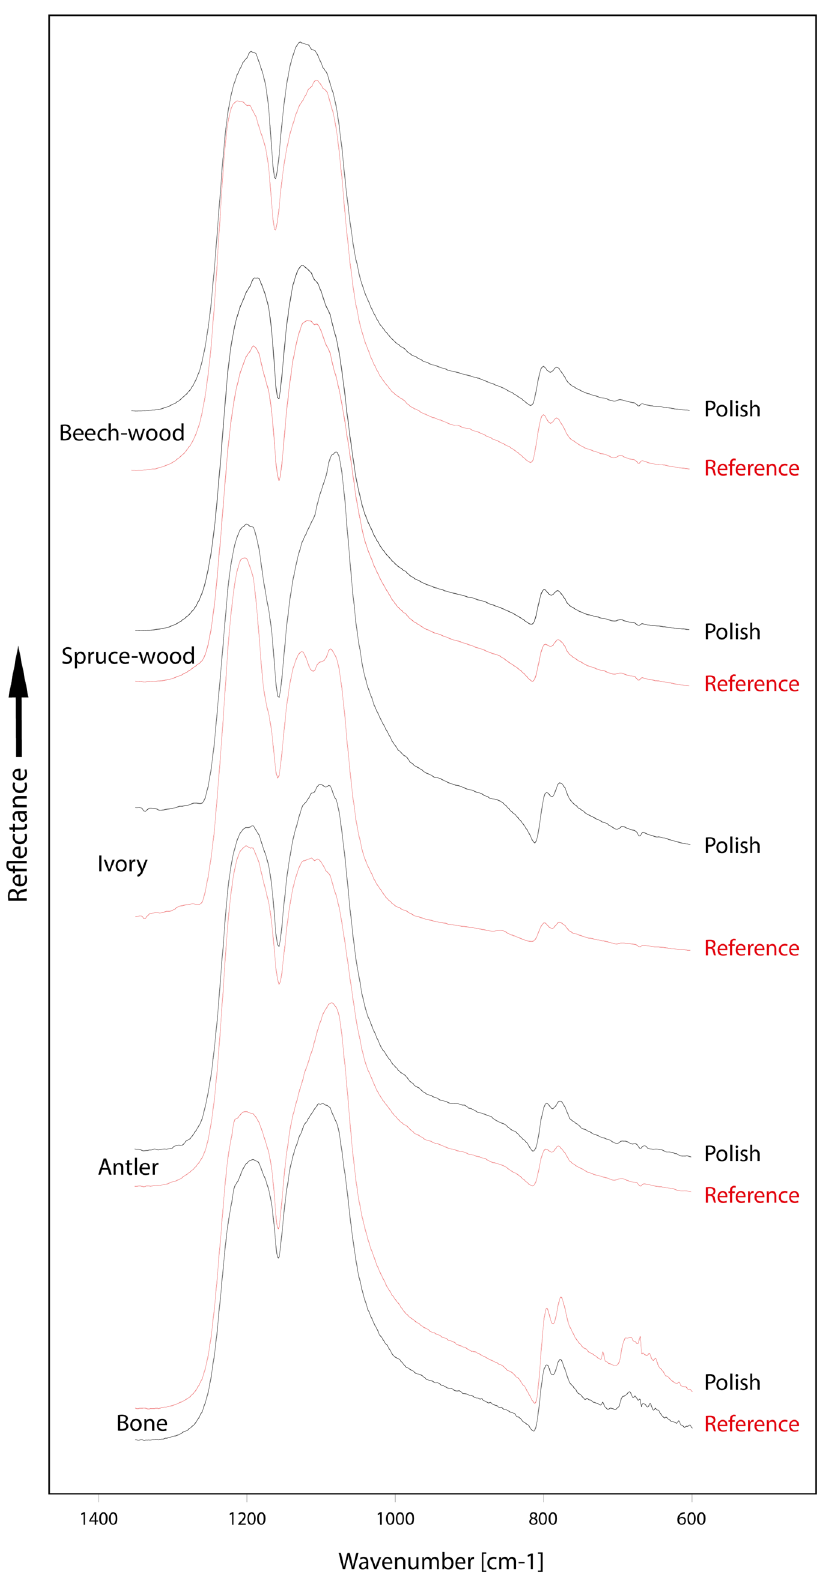
Figure 3. Reflection infrared spectra recorded on polished and unpolished zones of chert abrade against five target